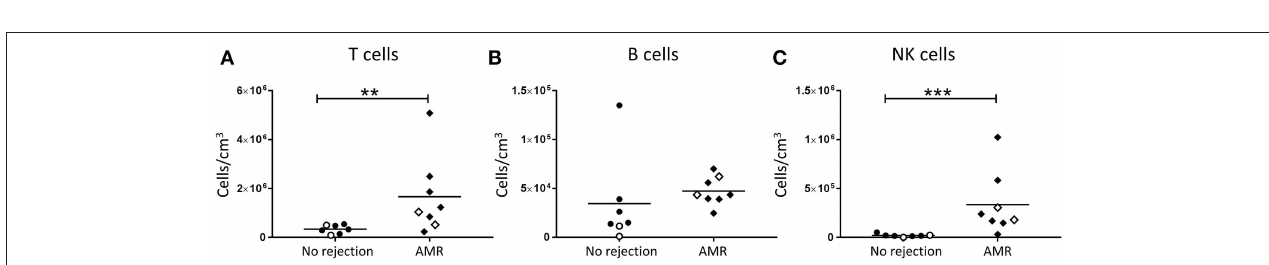
FIGURE 3 | Significantly increased T cells and NK cells in AMR. Absolute numbers of total (A) T cells, (B) B cells, and (C) NK cells in kidney transplant biopsy tissue with histopathological diagnosis of no rejection ( n = 7) and with indication of AMR (AMR; n = 8). Values for individual donors are presented; donors with DSA are